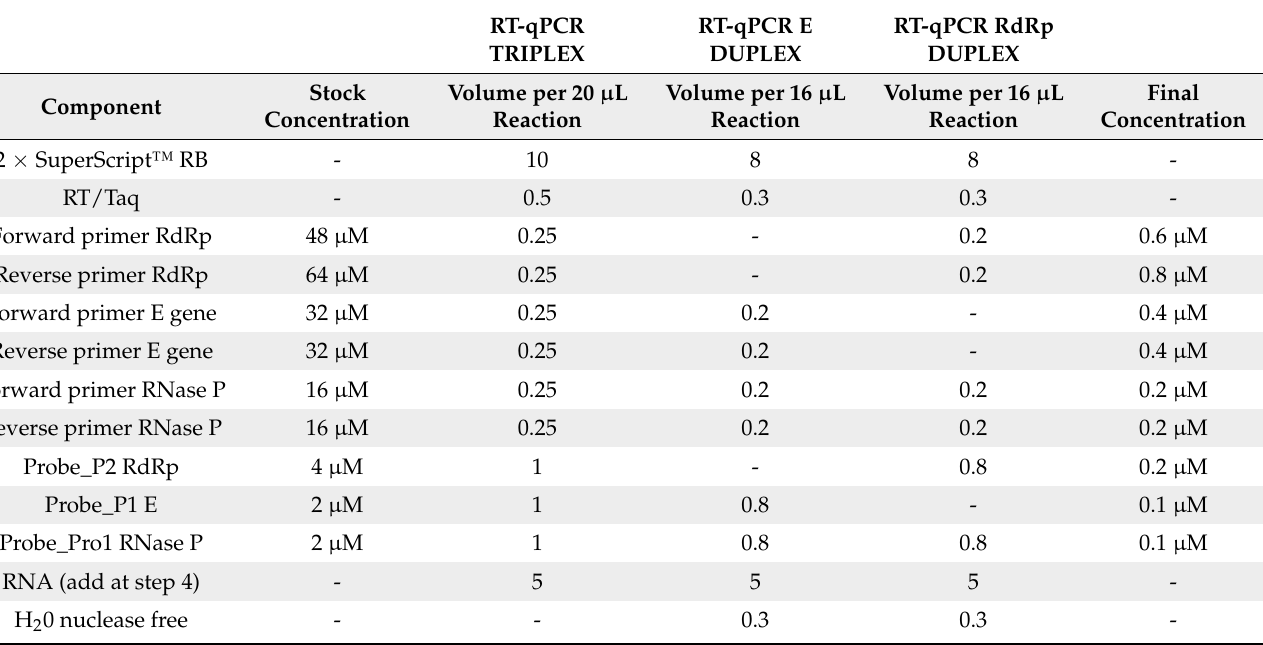
Table 2. Components for the preparation of the triplex and duplex RT-qPCR master solution for detecting viral E, RdRp, and RNase P genes as internal control for the diagnosis of